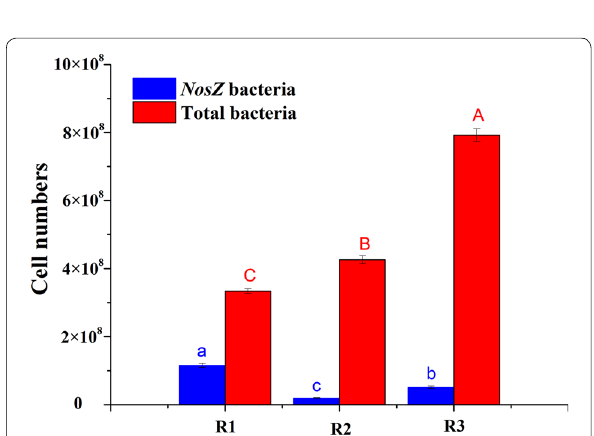
Fig. 4 Absolute abundance of nosZ and 16 s rRNA cells of all samples using quantitative real‑time PCR. Values (mean color column with different letters are significantly different (P <